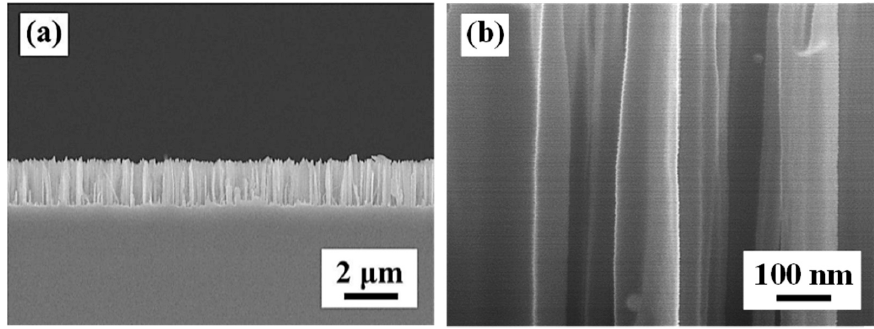
Figure 5. Cross-sectional SEM images of the SiNWs. ( a ) Low rate and ( b ) high rate.